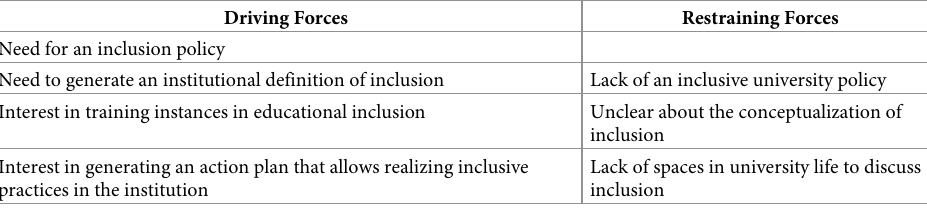
Table 2. Driving and restraining forces transversal to a group of students, teachers and non-teaching staff.